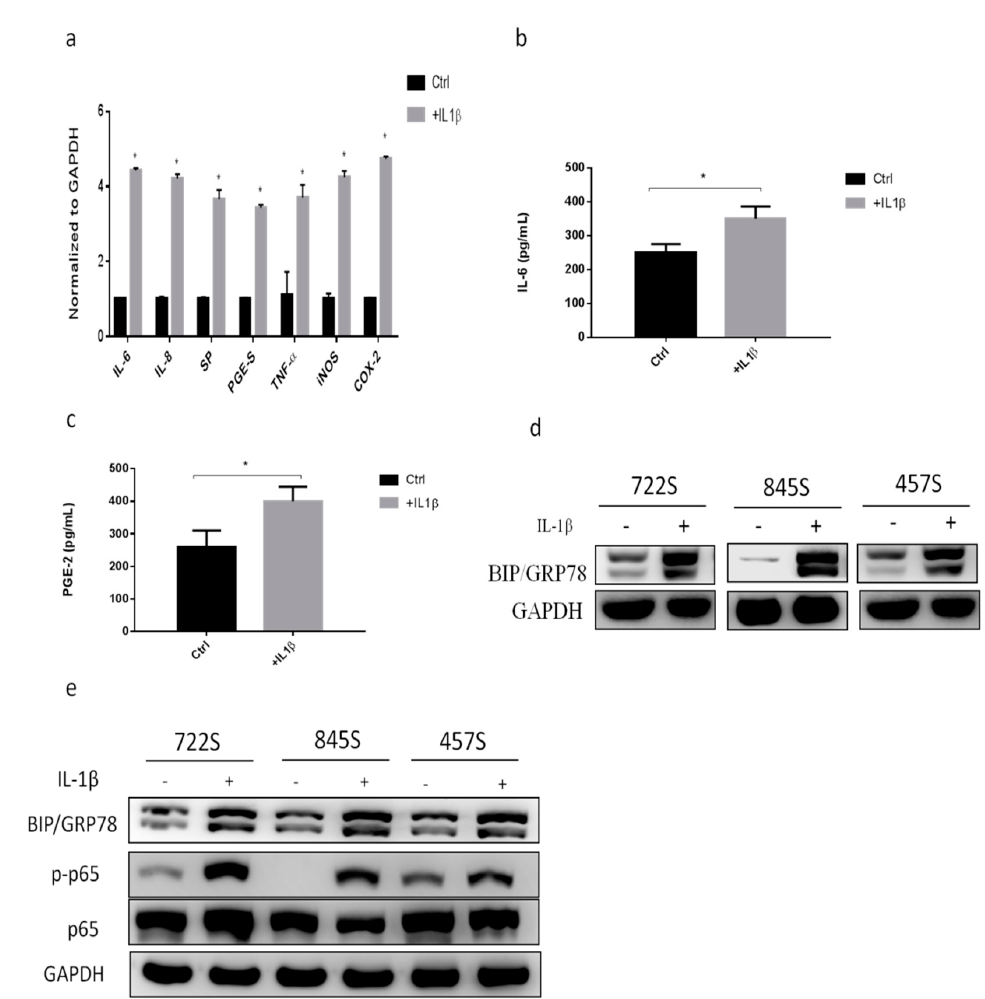
Figure 1. Effects of IL-1 β on the inflammatory factors and GRP78 in primary synoviocytes of OA patients. Primary synoviocytes were treated with IL − 1 β (10 ng/mL) for 24 h. ( a ) Quantitative PCR analysis of IL − 6, IL − 8, SP, PGE − S, TNF −α , iNOS, and COX2. ( b , c ) ELISA analysis of IL − 6 and PGE2. ( d , e ) Western blot analysis of GRP78, p65 phosphorylation, and p65. Data are expressed as the mean ± SD, * p < 0.05. The data presented are representative of three independent experiments.